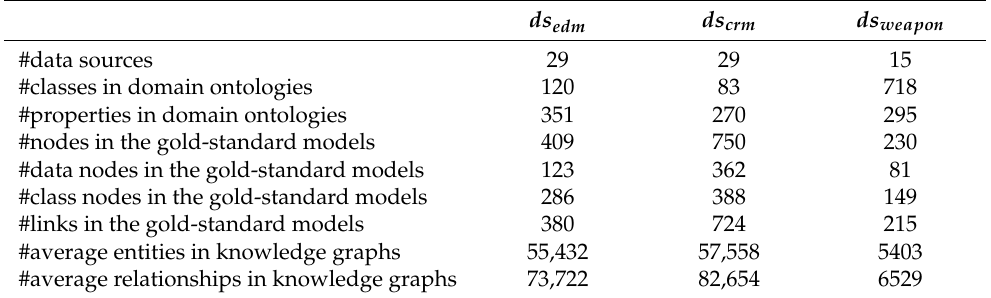
Table 2. The evaluation of datasets.